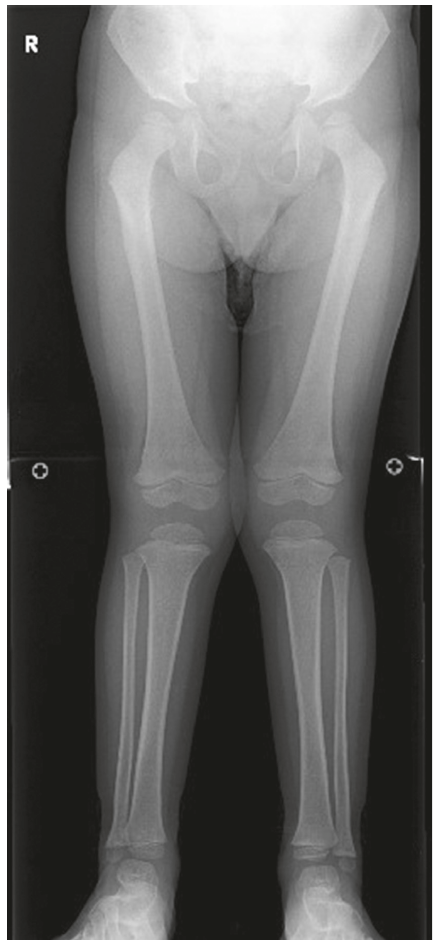
Figure 8: Genu valgum.